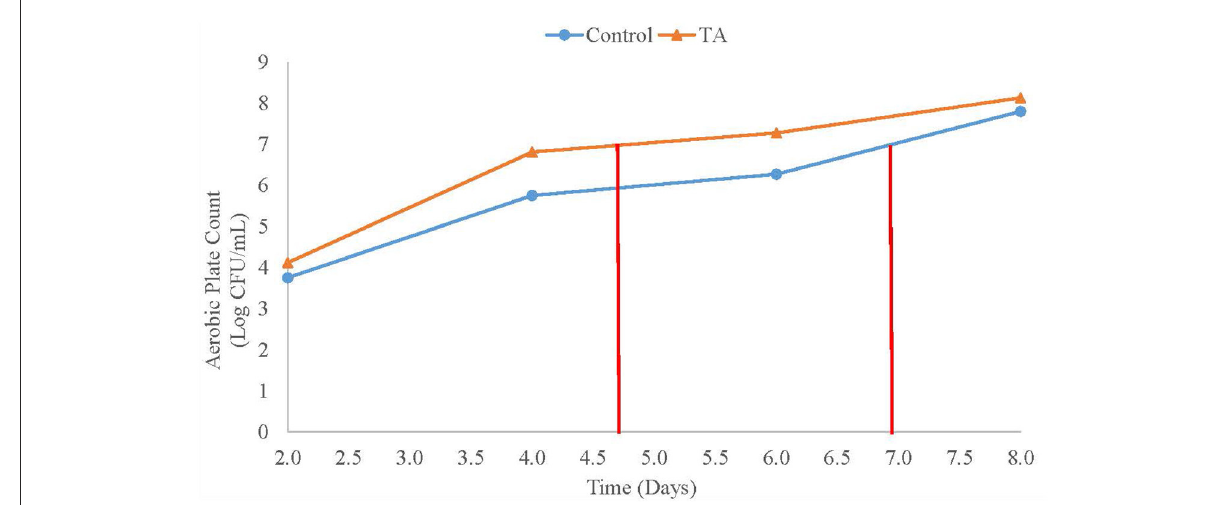
FIGURE9 APC shelf-life of simulated less-than-truckload temperature abused (TA; 2h at 4 ◦ C then 2h at 25 ◦ C) and control chicken breast filets kept in simulated retail conditions.